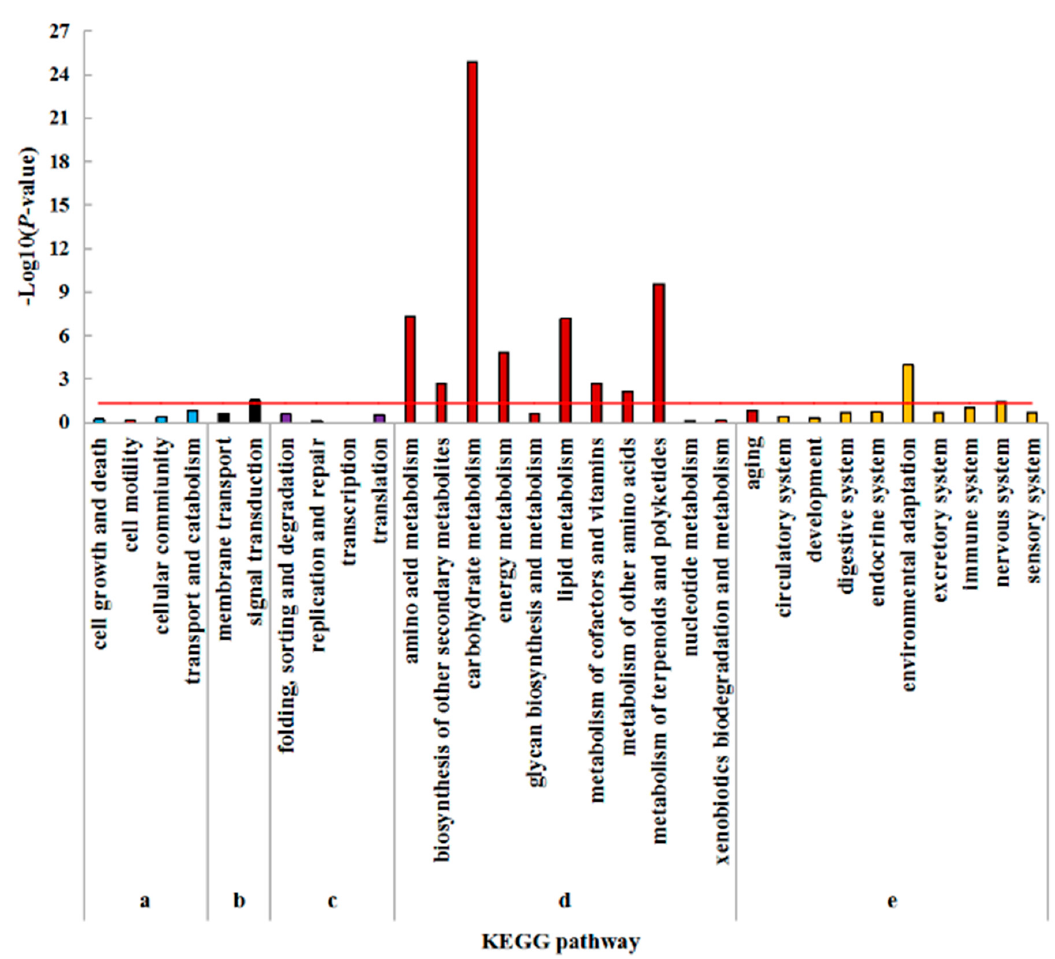
Figure 4. KEGG pathway enrichment analysis of DEGs in leaves under N- compared with CK. ( a ) Cellular processes; ( b ) Environmental information processing; ( c ) Genetic information processing; ( d ) Metabolism; ( e ) Organismal systems. The hypergeometric distribution calculates the p -value which determines the significance of enrichment, and the red line represents the p -value of 0.05.